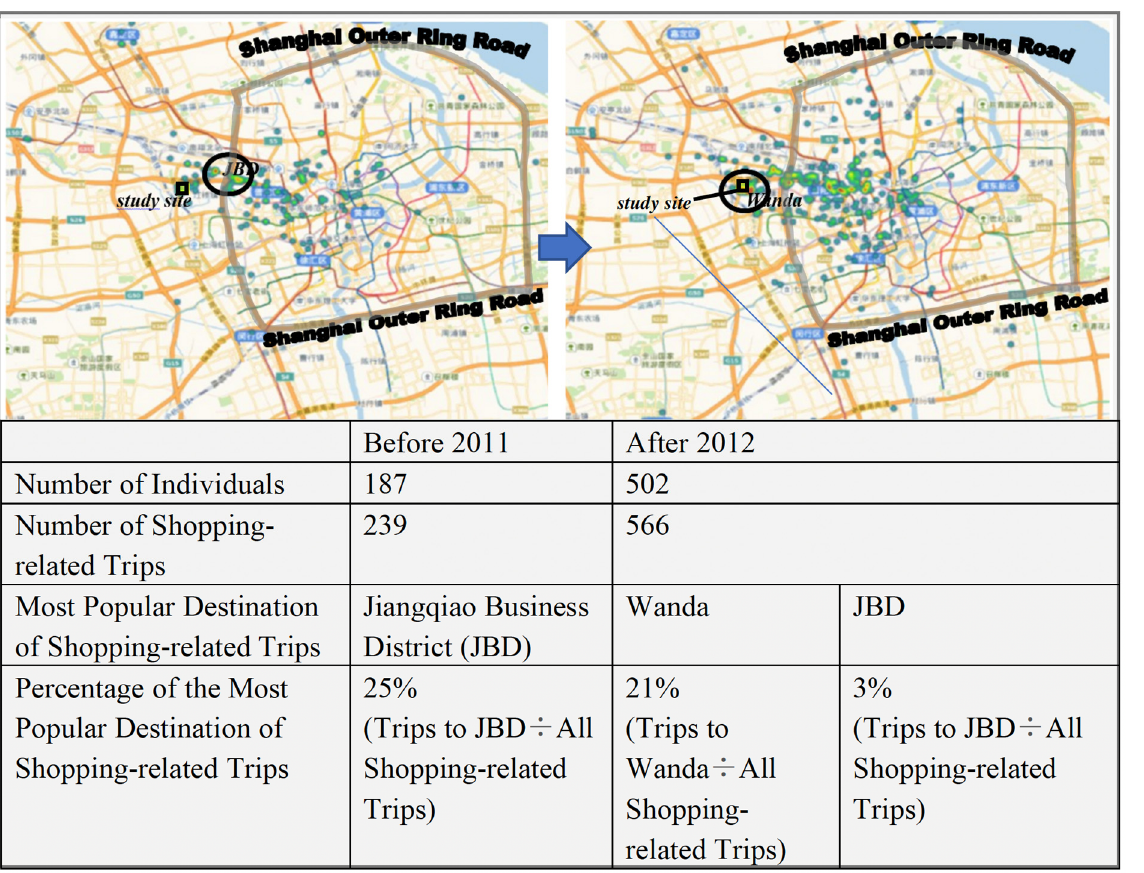
Figure 1. Shopping-Related Trips’ Destinations Before and After Wanda Shopping Plaza was open (Left Heat Map: Before Wanda Shopping Plaza was open, in 2011; Right Heat Map: After Wanda Shopping Plaza was open, in 2012; Wanda and JBD are shown as the red spots within the black circles in the two maps).